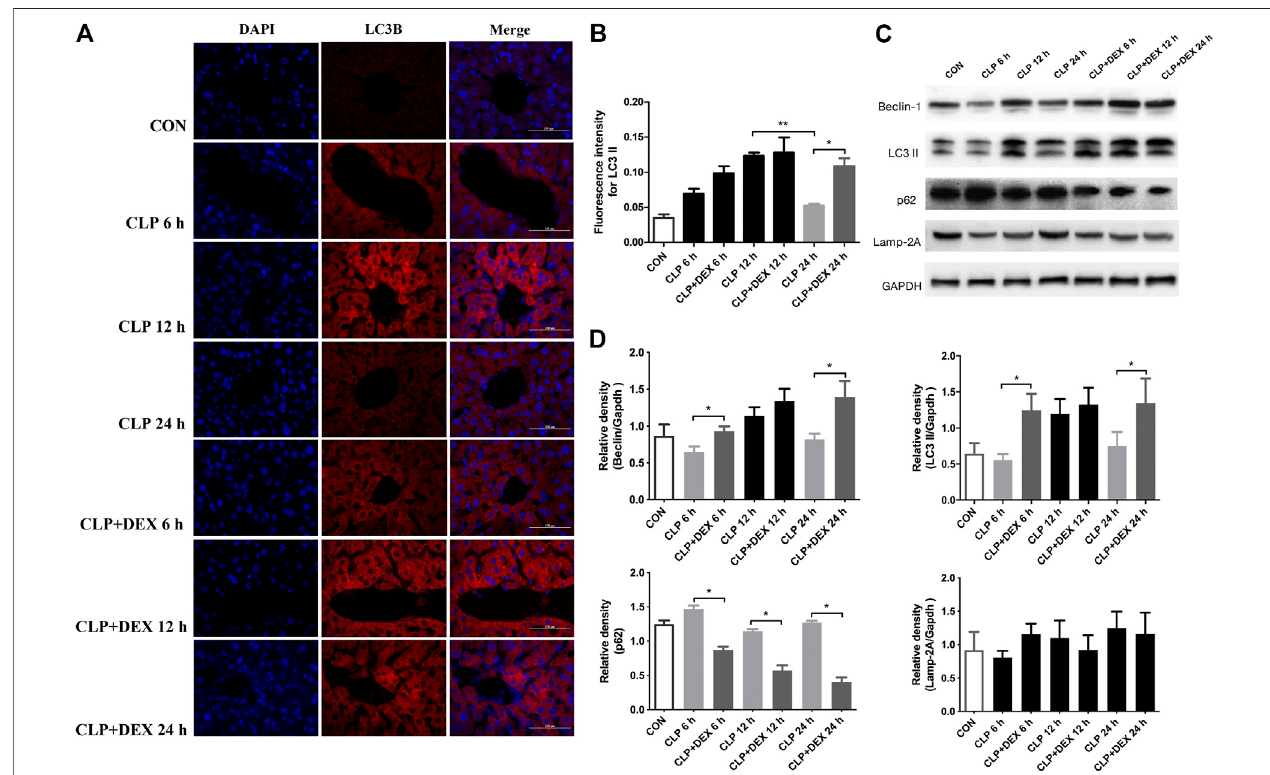
FIGURE 3 | Effect of DEX on the autophagic activity in the livers of mice after CLP surgery. (A) The positive expression of LC3II in liver tissue, as detected using immuno fl uorescence staining (magni fi cation: × 400). (B) Analysis of the immuno fl uorescence intensity for LC3II from (A) . (C) The protein expression of Beclin-1, LC3II, p62, and LAMP-2 in liver tissues, as determined using western blotting. (D) Densitometric analysis of Beclin-1, LC3II, p62, and LAMP-2 from (C) . Error bars on the bar graphs represent the mean ± SD. * p <